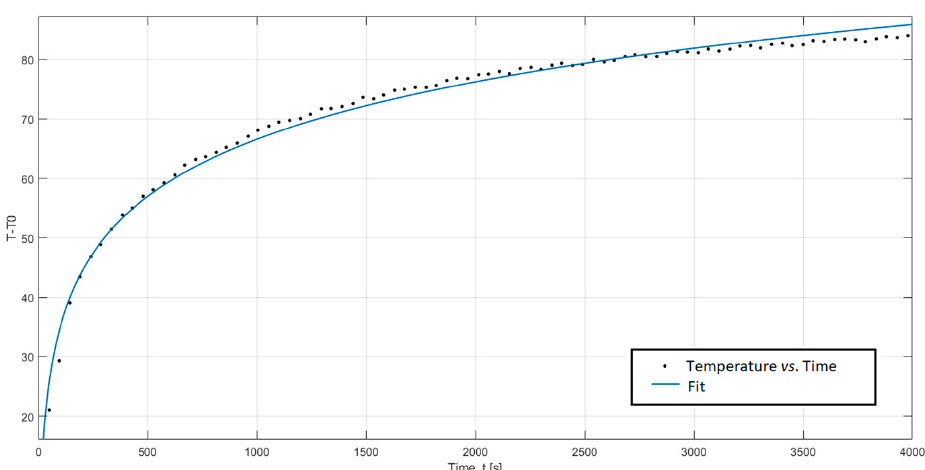
Figure 7. Heating curve. Skamol SM-65 sample.